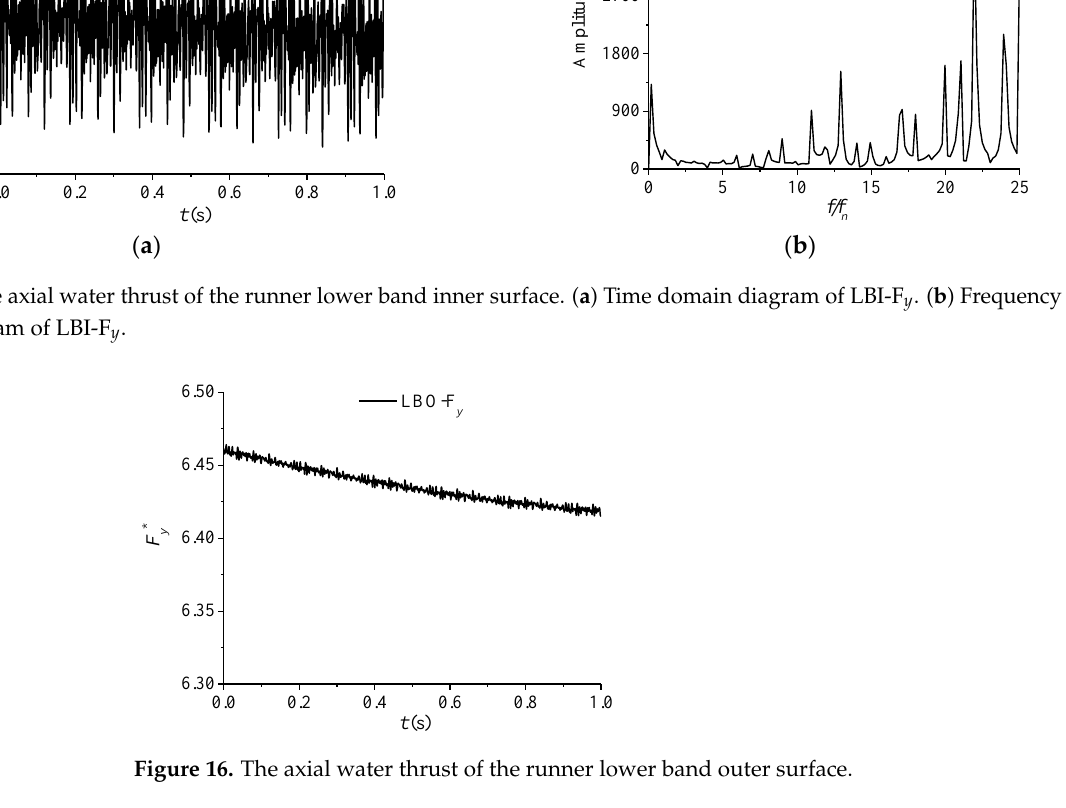
Figure 16. The axial water thrust of the runner lower band outer surface.